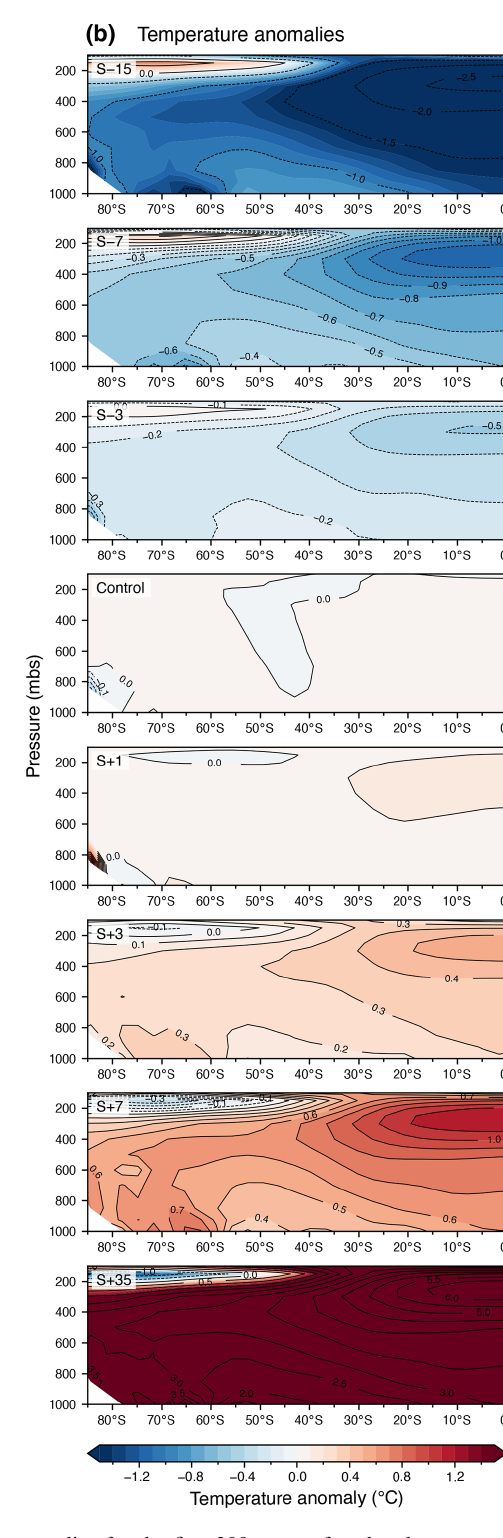
Figure 14. Atmospheric profiles for the Southern Hemisphere mean anomalies for the first 200 years of each solar constant experiment. Anomalies are calculated relative to the long-term control. (a) Zonal wind anomalies (shaded) and contours of the control zonal wind (lines). (b) Temperature anomalies (shaded), where contour lines of the temperature anomaly are additionally shown in 0.5 ◦ C increments to assist in interpreting S − 15 and S +